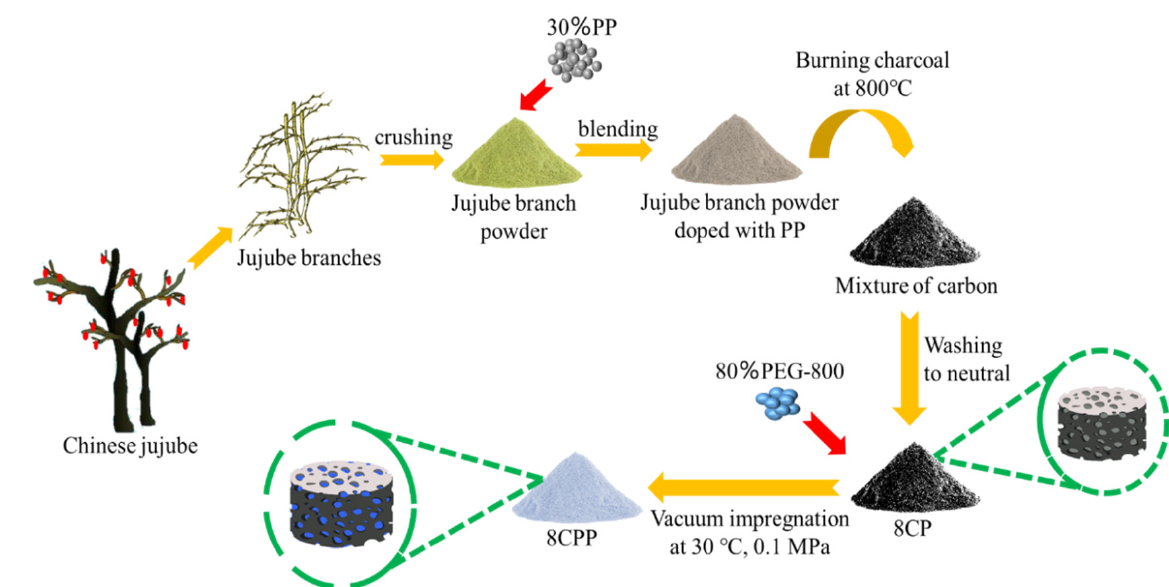
Figure 1. The preparation process for the 8CPP.